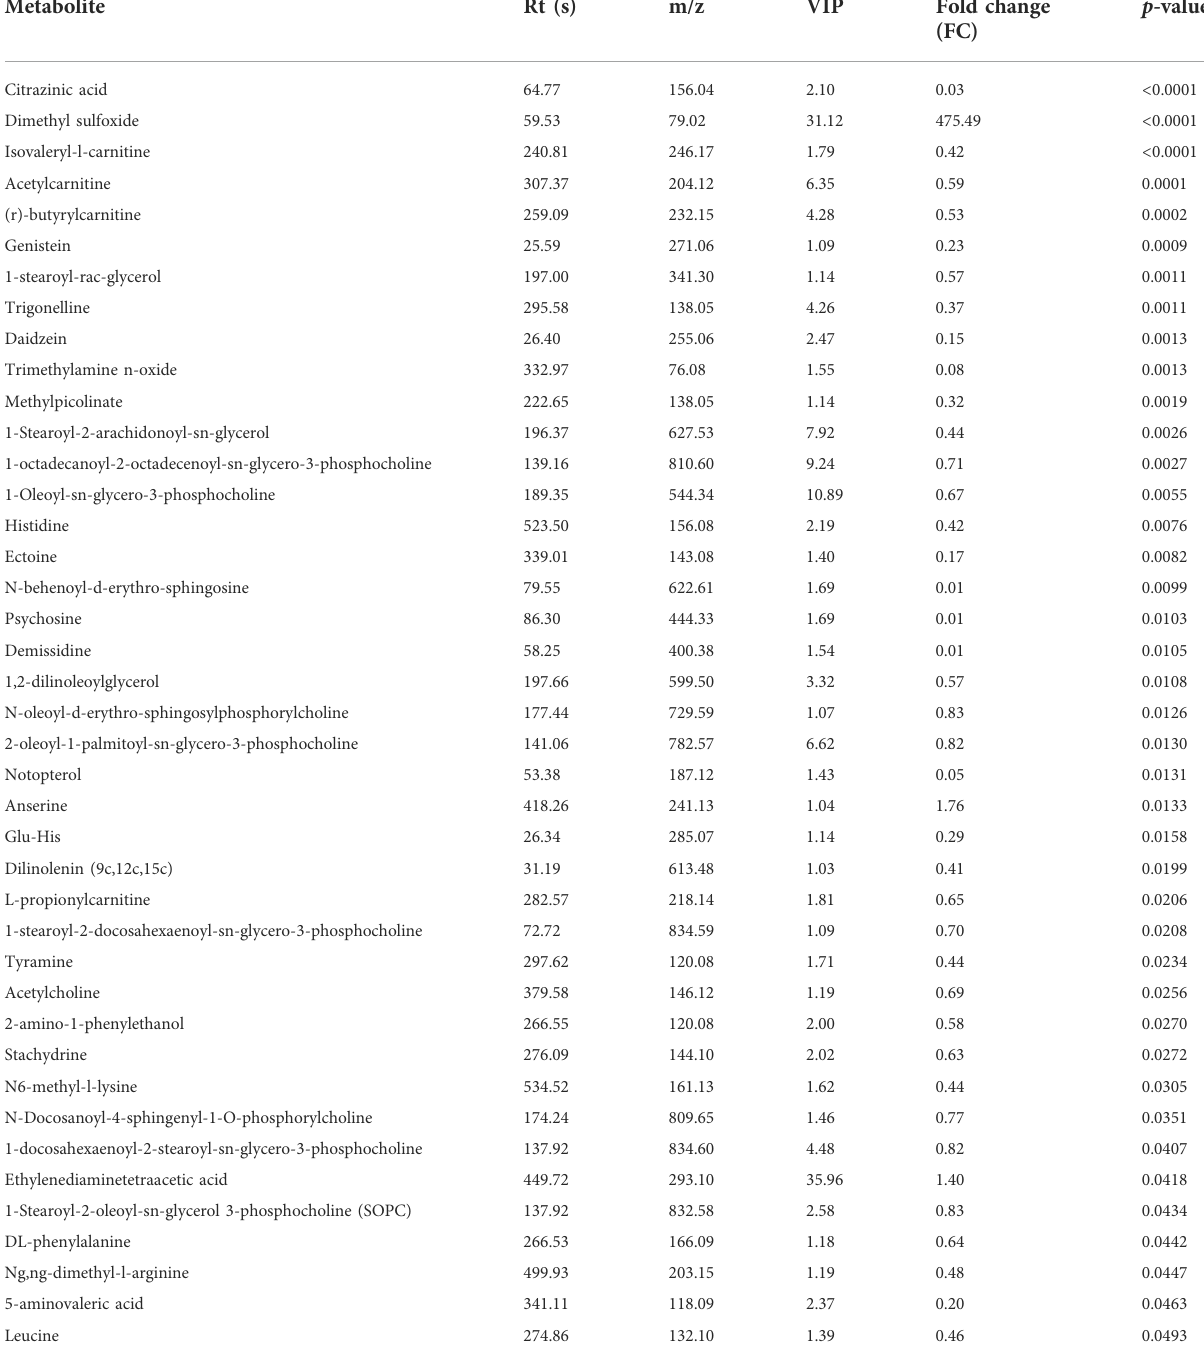
TABLE 2 Identi fi ed differentially expressed metabolites between HGWD-treated and control groups of mice (positive ion).